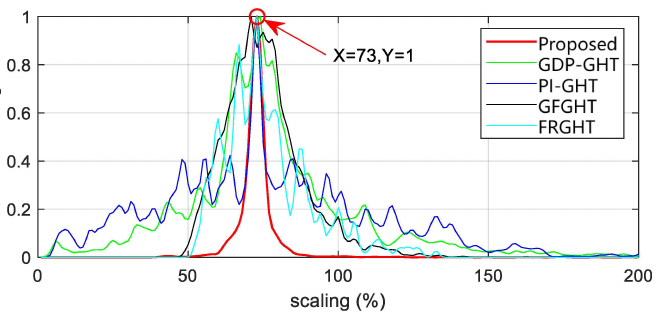
Figure 10. The voting space for scale for the most-challenging shape S2 with the configuration of rotation = 53 ◦ and scale =